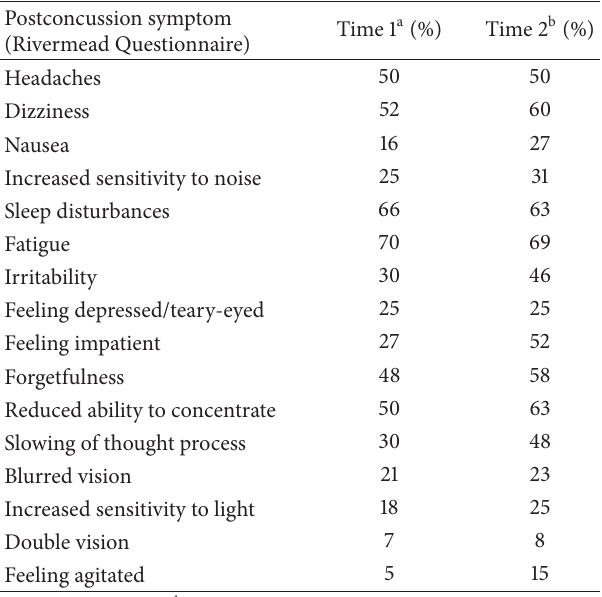
Table 2: Prevalence of postconcussion symptoms following mild traumatic brain injury (MTBI).